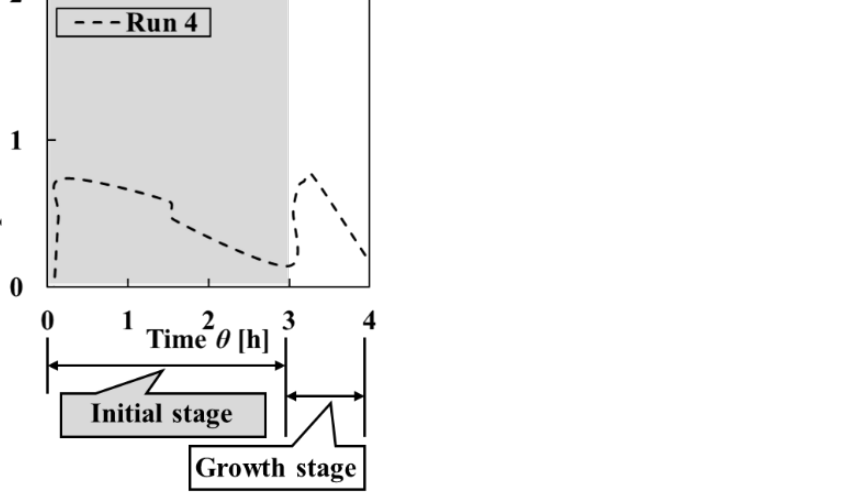
Figure 7. Change in the supersaturation calculated from the measured pH and L-Asp concentration of the solution in Run 4.